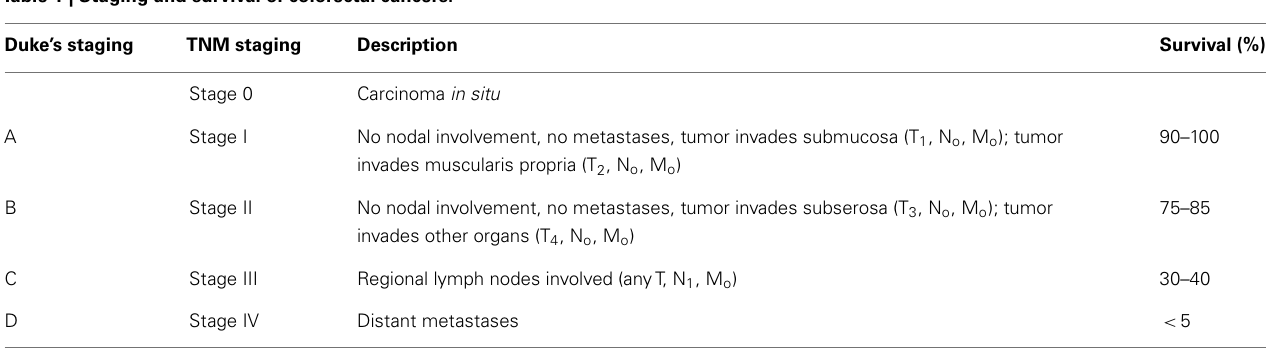
Table 1 | Staging and survival of colorectal